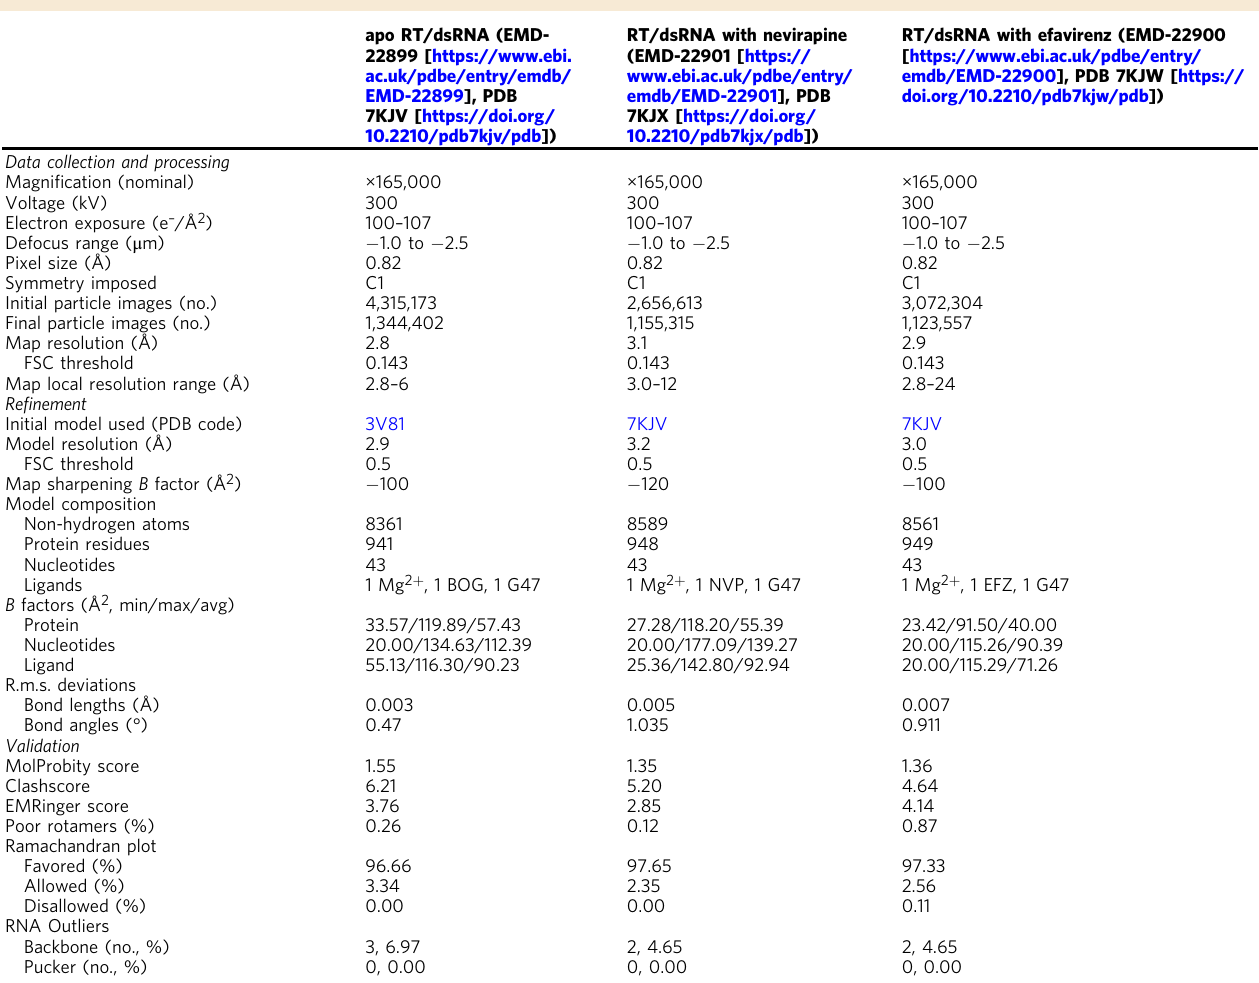
Table 1 Cryo-EM data collection, re fi nement, and validation